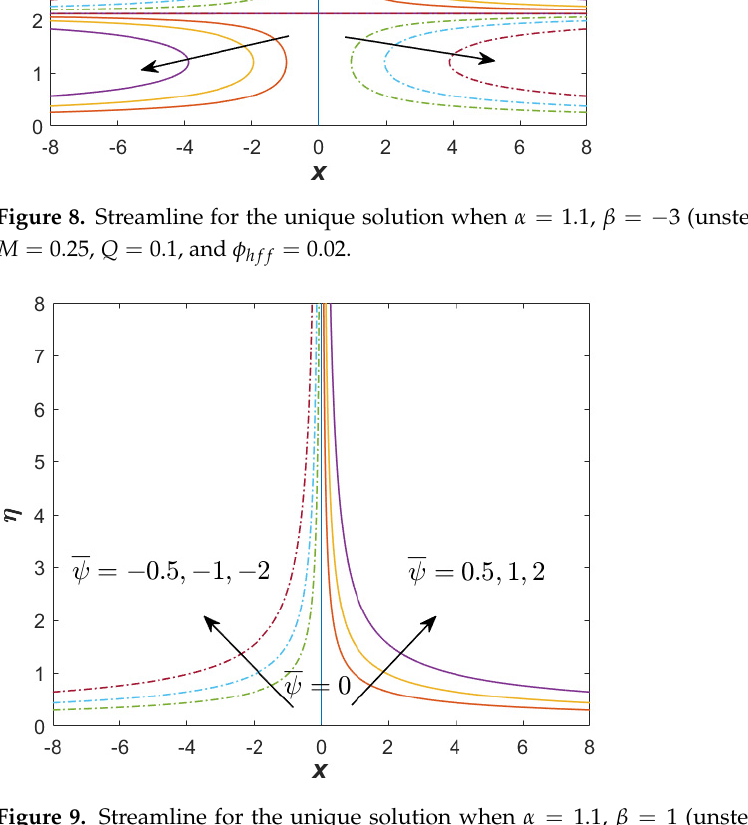
Figure 9. Streamline for the unique solution when α = 1.1, β = 1 (unsteady accelerating flow), M = 0.25, Q = 0.1, and φ hf f = 0.02.